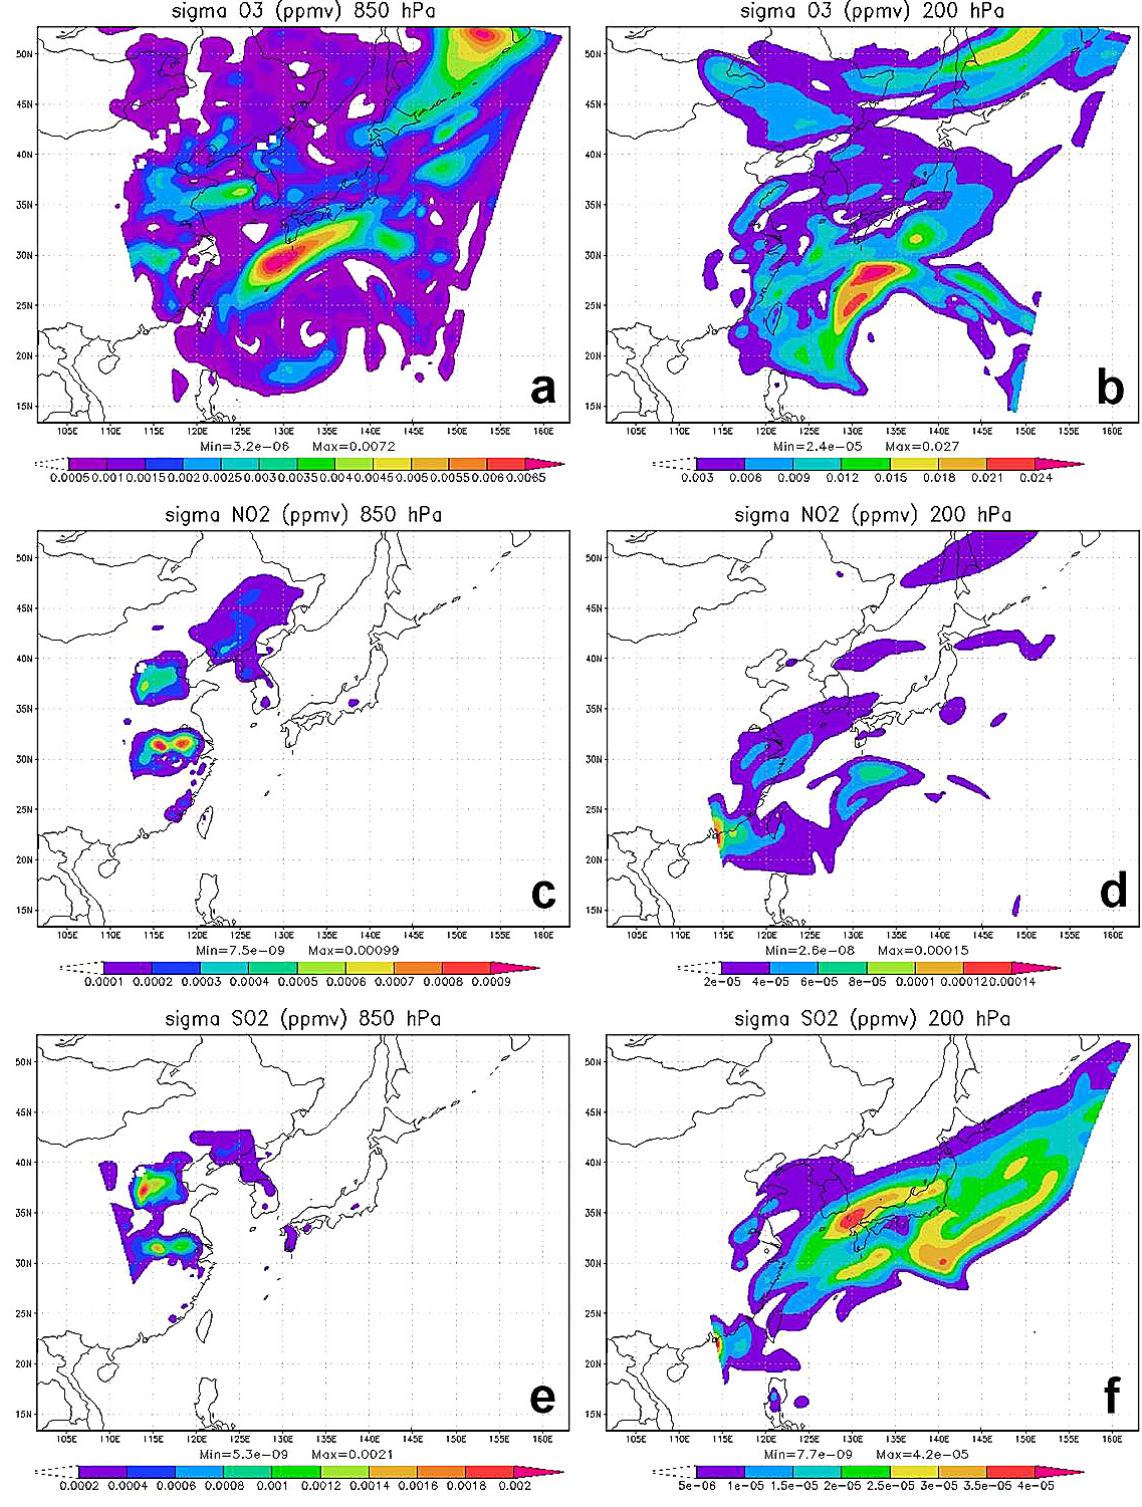
Figure 2. Standard deviation of background error covariance for chemical variables valid on 06:00UTC, 3 September 2005 at 850hPa (left panel) for (a) O 3 , (b) NO 2 and (c) SO 2 , and at 200hPa (right panel) for (d) O 3 , (e) NO 2 and (f) SO 2 . Units are